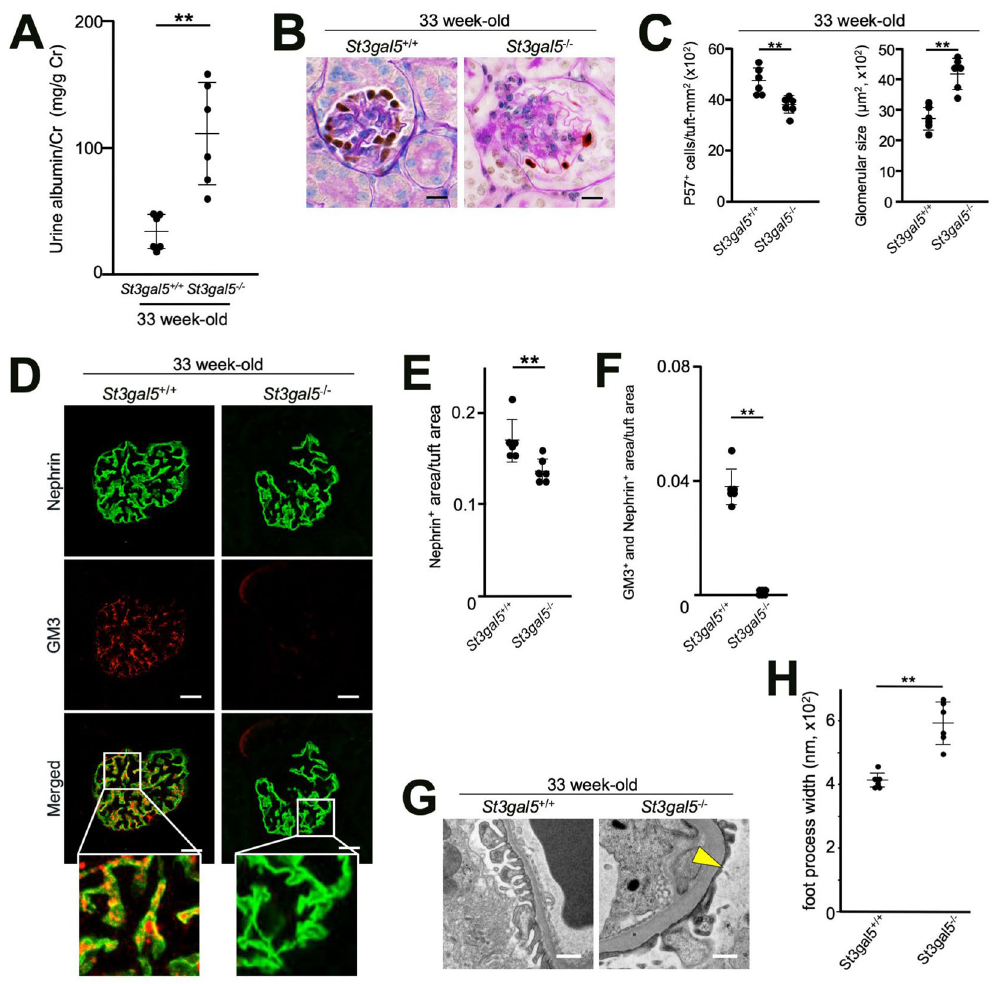
Figure 3. Podocytopathy in aged GM3 synthase gene knockout ( St3gal5 −/− ) mice. ( A ) Scatter diagram showing urine albumin to creatinine. ** P < 0.01 vs. wild-type ( St3gal5 +/+ ) mice. ( B ) p57 (podocyte marker, brown) and PAS staining of glomeruli. Scale bars: 20 µm. ( C ) Bar graphs showing p57 + cells/tuft (left) and glomerular size (right). ** P < 0.01 vs. St3gal5 +/+ . ( D ) Immunofluorescence staining images of glomeruli. Scale bars: 20 µm. Nephrin (green) and GM3 (red) merged areas (yellow) highlighted in enlarged images. ( E ) Scatter diagram showing nephrin fluorescence area/tuft area, ( F ) GM3 and nephrin merged fluorescence area/tuft area. ** P < 0.01 vs. St3gal5 +/+ . ( G ) Images of podocyte foot processes by transmission electron microscopy. Yellow arrowhead showing areas of foot process effacement. Scale bars: 10 µm. ( H ) Scatter diagram showing quantification of foot process effacement. ** P < 0.01 vs. St3gal5 +/+ . Twenty glomeruli per mouse were analyzed in each group. Statistical analyses were performed from mice (n = 6) in each